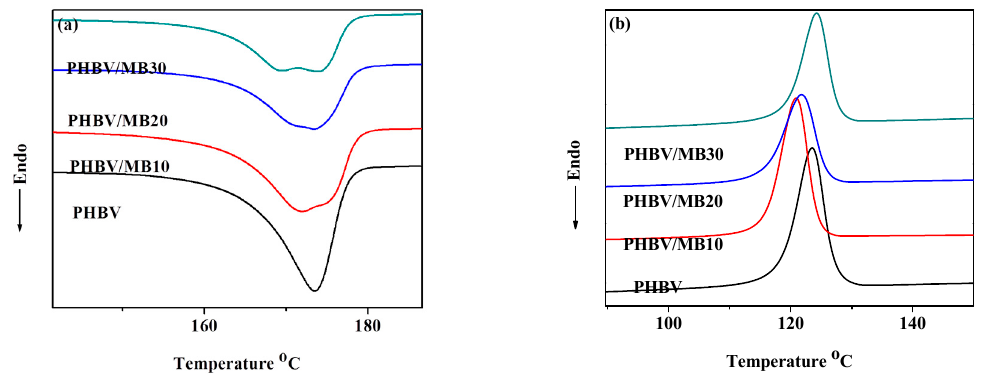
Figure 5. DSC thermograms of the PHBV and PHBV / MB composites during: ( a ) first heating run; ( b ) first cooling run. Table 2. The melting and crystallization temperatures ( T m1 , T m2 and T c ) and the degree of crystallinity ( χ c ) of the PHBV and PHBV / MB composites measured with DSC.